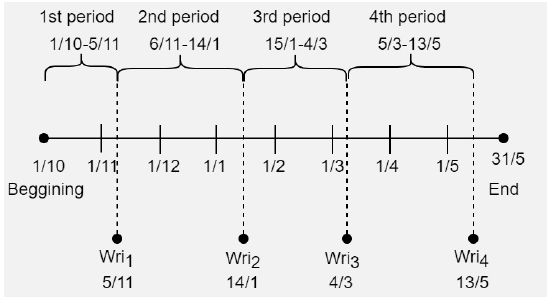
Figure 3. Time-periods of the academic year.